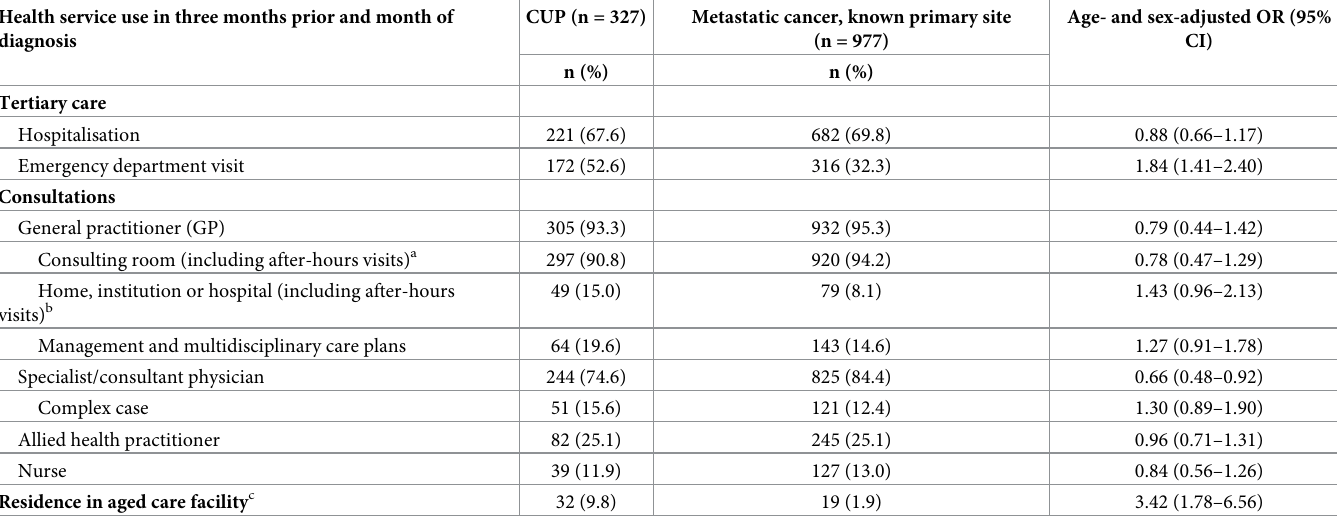
Table 1. Association between recent health service use and diagnosis of CUP compared to metastatic cancer of known primary. Health service use in three months prior and month of